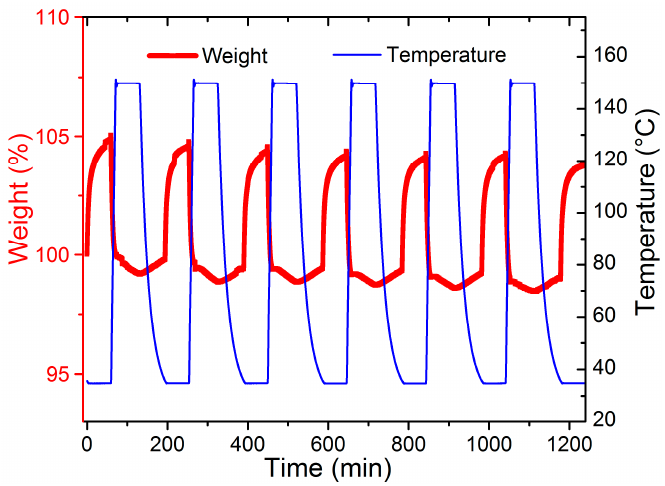
Figure 6. CO 2 adsorption and desorption cycle of MIP-207-NH 2 -25%.